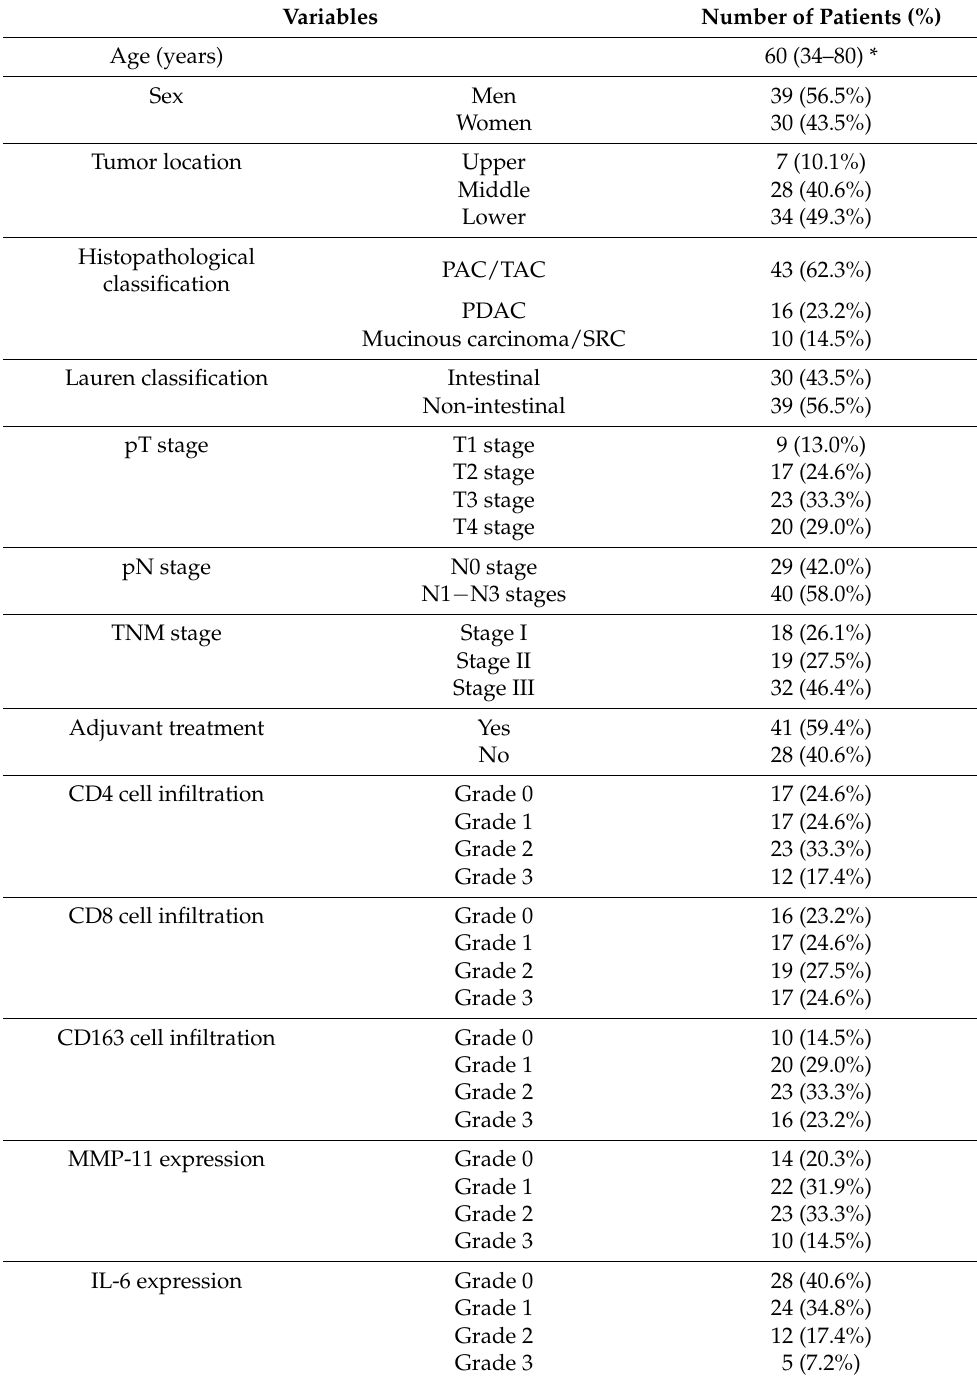
Table 1. Characteristics of the 69 enrolled patients with gastric